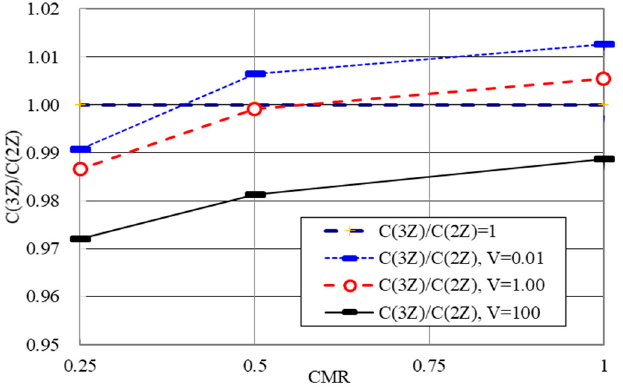
Figure 11. Total cost for various gamma distributions ( θ = 0.3).